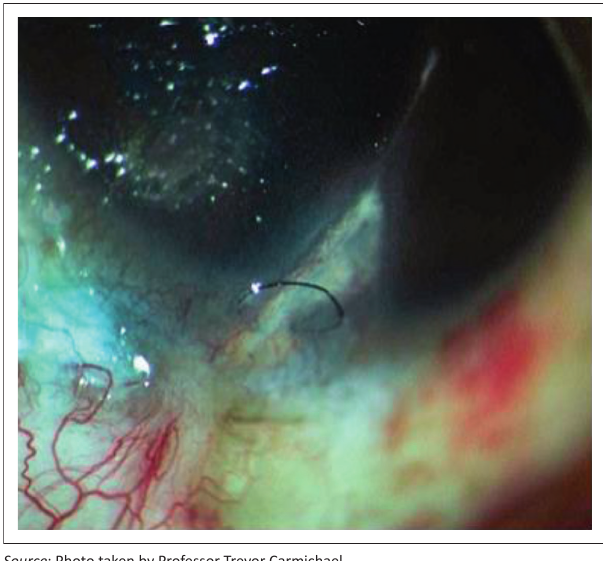
Source : Photo taken by Professor Trevor Carmichael FIGURE 2: One week after operation, with a suture in place. Note that inflammation has decreased with early stromal vascularisation.